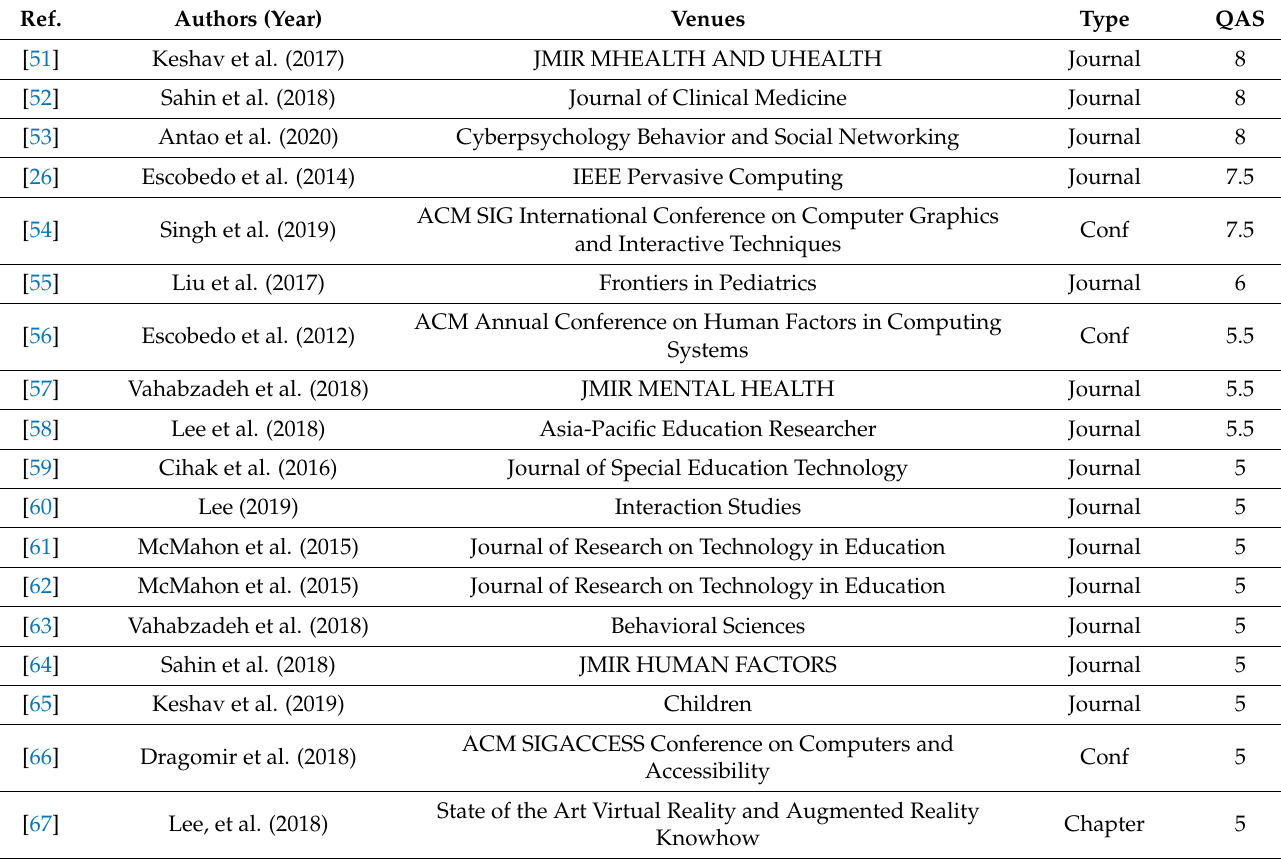
Table 3. This is the QA score and paper types and venues of the selected studies.